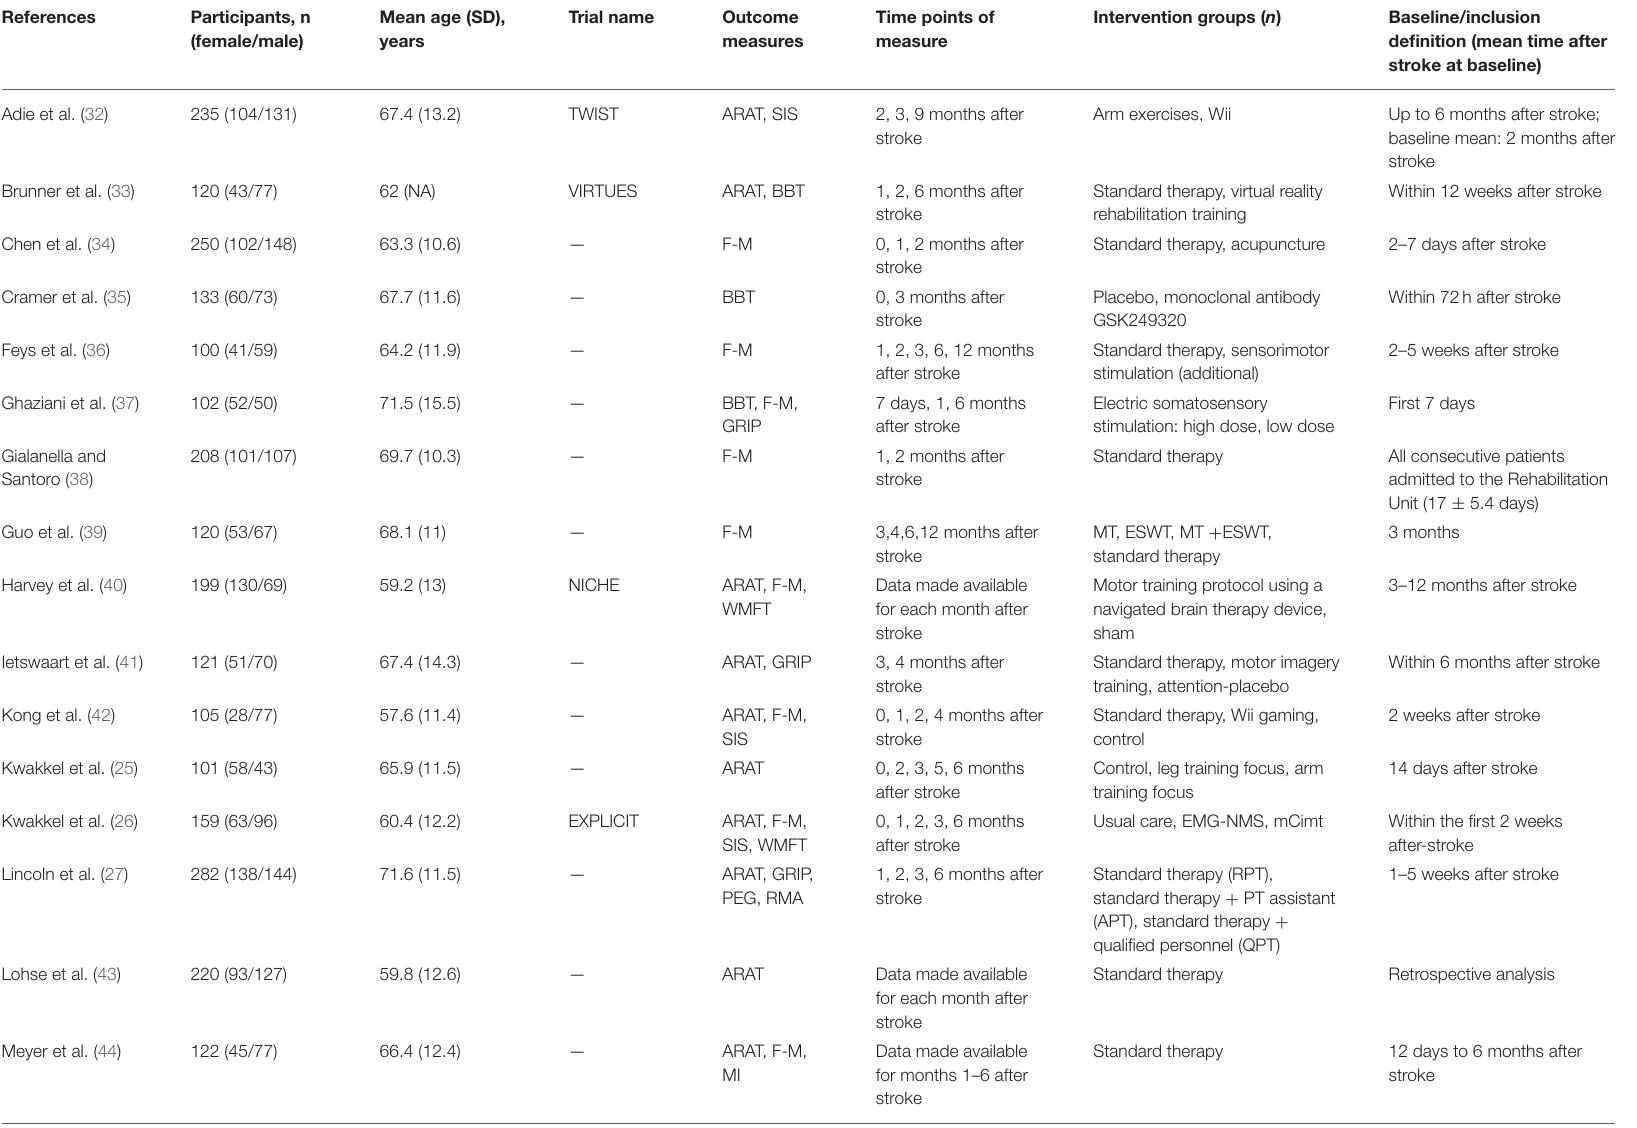
TABLE 3 | Characteristics of included studies (alphabetical